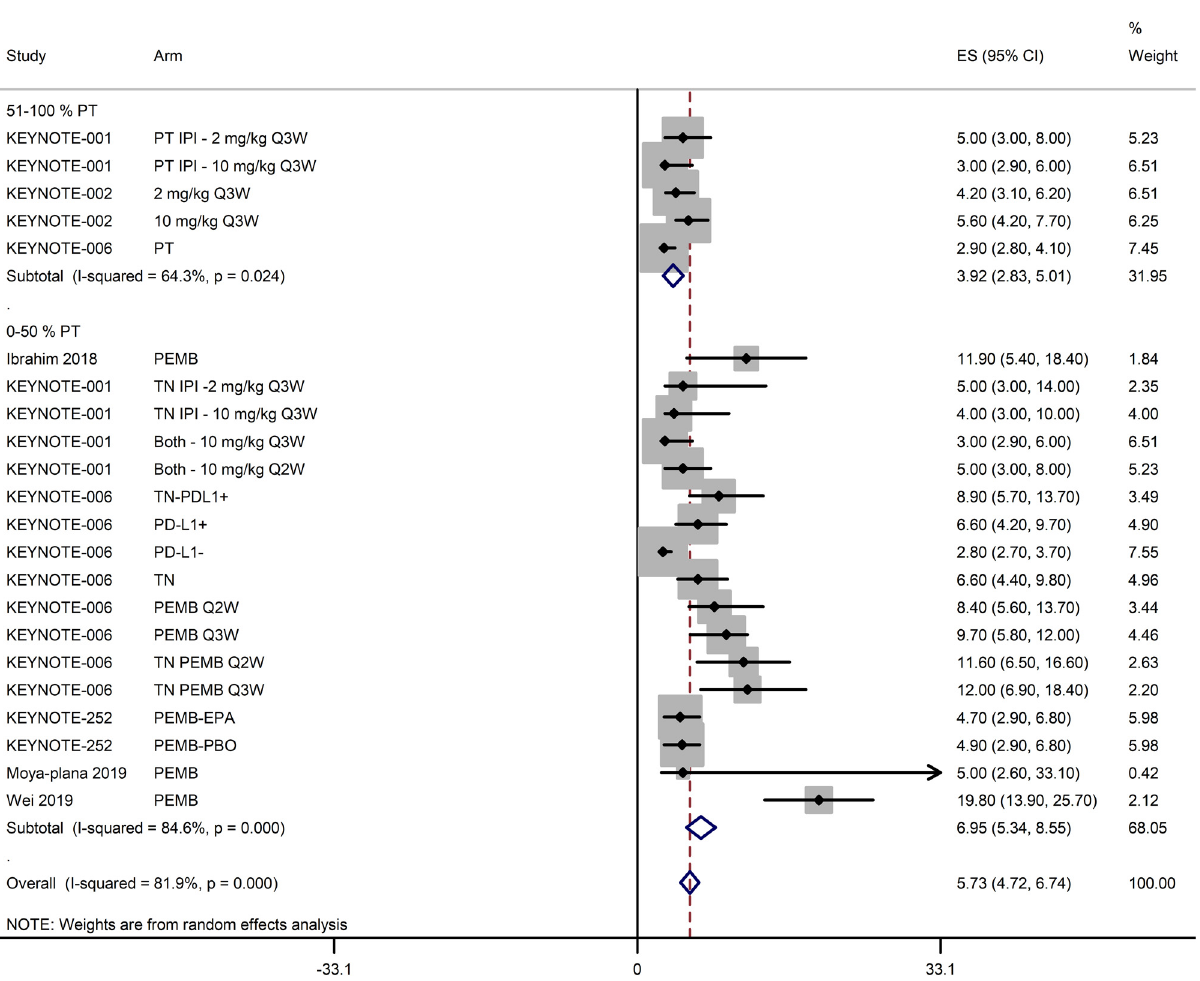
Figure 3: A forest graph showing the pooled PFS ( ES; e ff ect size with 95% CI ) with regards to the percentage of patients with prior